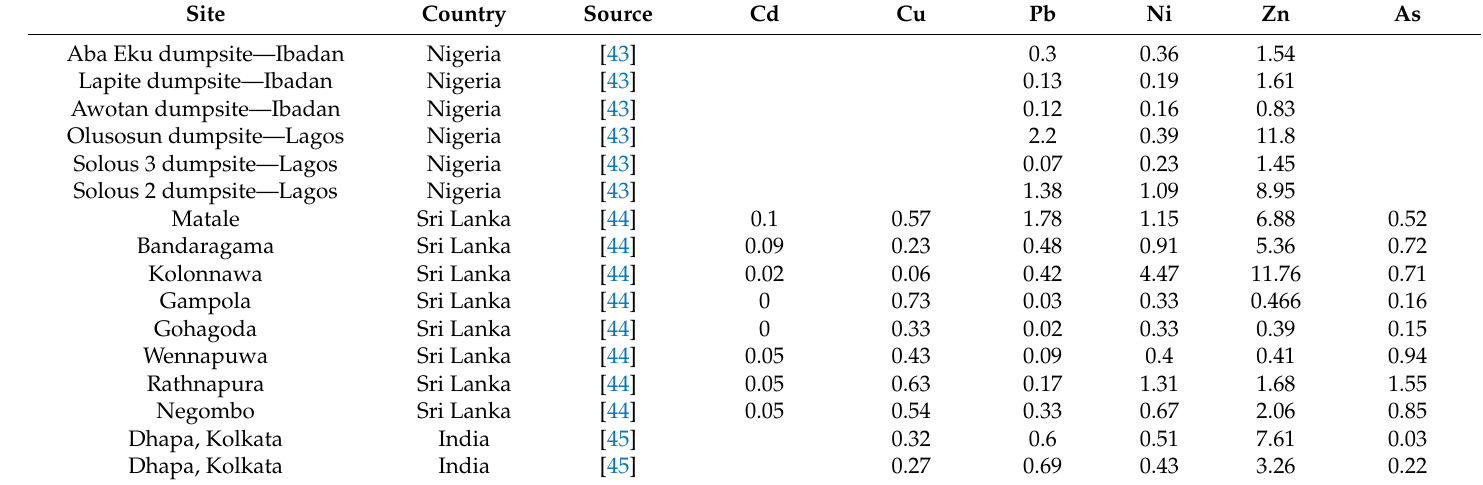
Table A1. Data related to the dumpsites taken as reference. The concentrations of inorganic pollutants in the leachate are expressed in